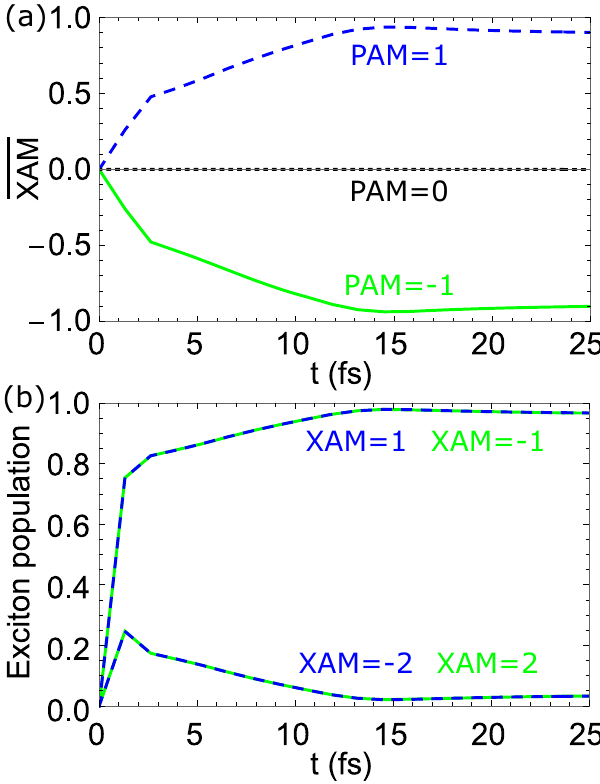
Fig. 10 OAM conservation. a XAM obtained for twisted light with PAM = − 1 (green), 0 (black), and 1 (blue). b Corresponding exciton Fig. 8 Twisted light to twisted exciton. Exciton populations in a 4 populations. nm long (3, 3) CNT illuminated by a twisted light pulse with PAM = = − 1 − 1 ( p 1 , p 7 ), 0 ( p 2 ), or 1 ( p 3 , p 8 ), twisted light pulses with PAM and 1 of the same amplitude ( p 4 ), twisted light pulses with PAM = − 1, 0, and 1 of the same amplitude ( p 5 ), and two twisted light pulses with PAM = − 1 of the same amplitude ( p 6 ). The CNT is initially in the ground state for p 1 to p 6 and in a 0.95:0.05 superposition of the ground state and excited states for p 7 and p 8